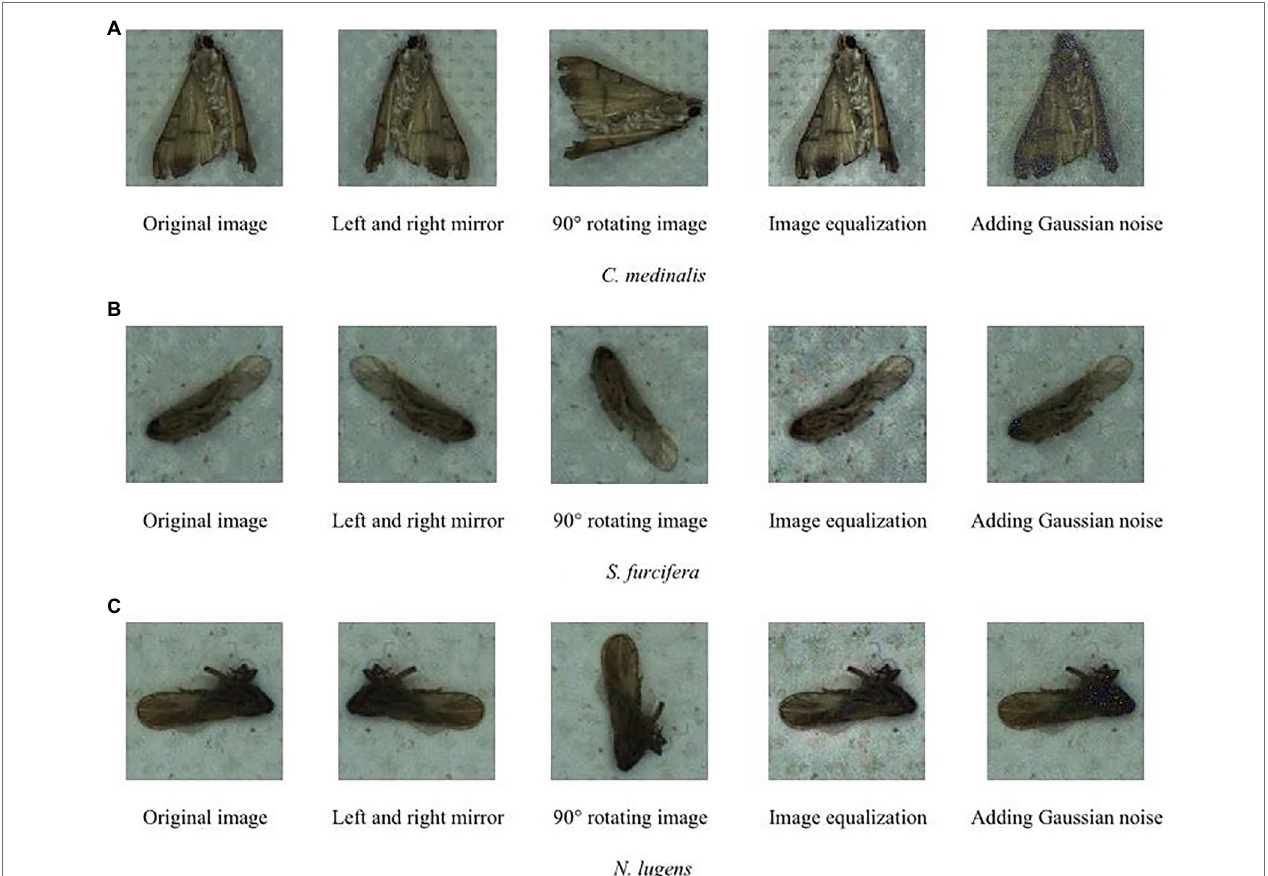
FIGURE 2 | Data enhancement of target pest images (A) C. medinalis , (B) S. furcifera , and (C) N. lugens